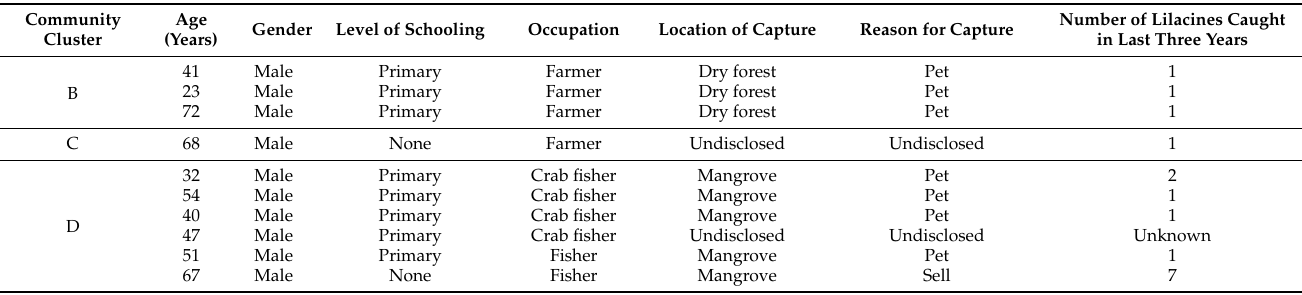
Table 5. The age, gender, schooling, and occupation of all interviewees who reported catching Lilacines in the last three years. We report the trapping location, reason for capture and how many were caught. Community